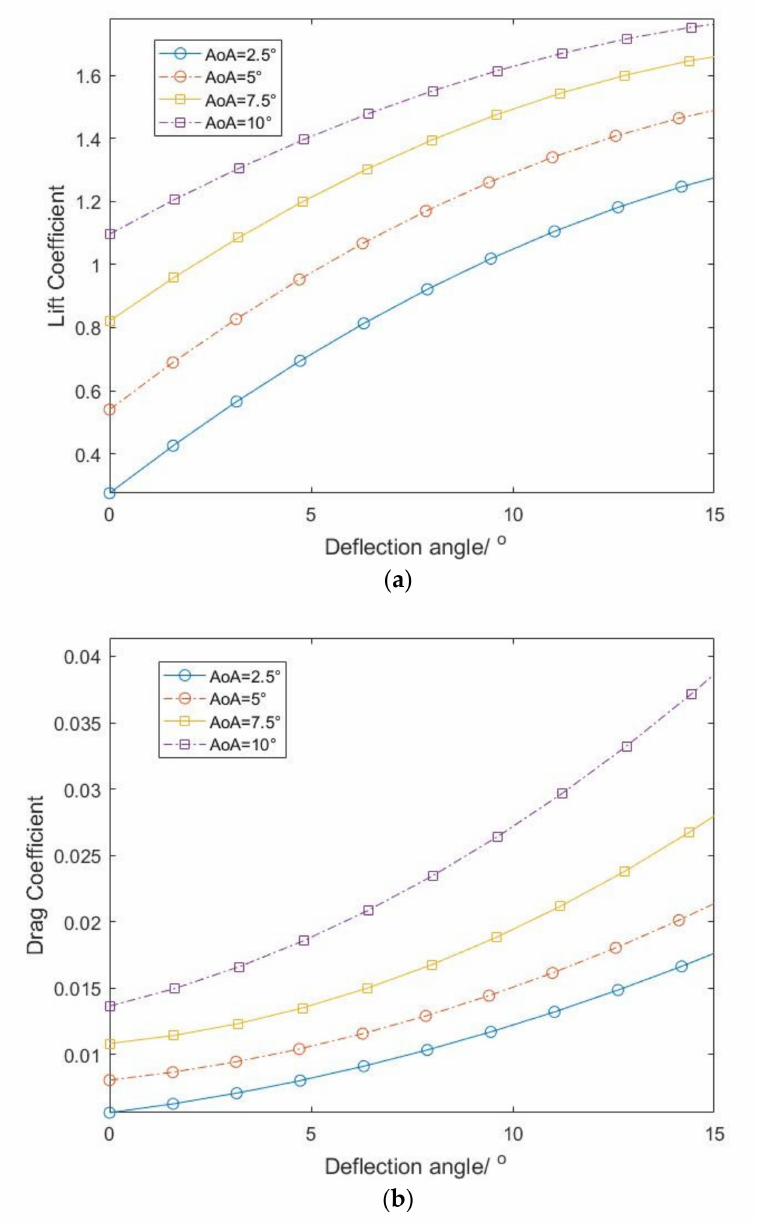
Figure 13. Deflection angle vs. aerodynamic coefficients: ( a ) deflection angle vs. lift coefficient; ( b ) deflection angle vs. drag